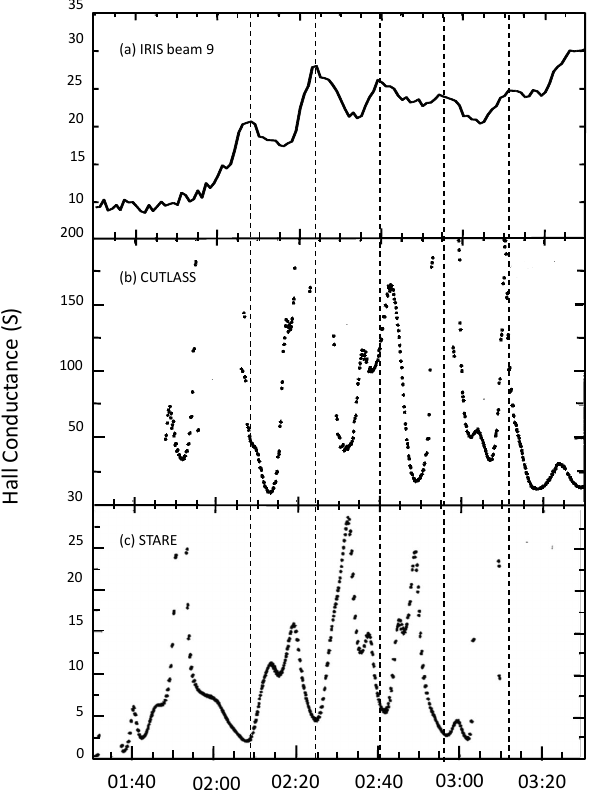
Fig. 7. A comparison of Hall Conductance estimates. Panel (a) is derived from Eq. (1) for data from beam 9 (over TRO) of IRIS. Pan- els (b) and (c) are taken from Wild et al. (2000) and correspond to estimates using the TRO magnetometer with beam 9 of CUTLASS and beam 4 of STARE respectively. Vertical dashed lines indicate the times of peak conductance according to IRIS. Peak magnitudes are comparable between (a) and (c) whereas the timing of peaks and troughs of the Ps6 match well between (a) and